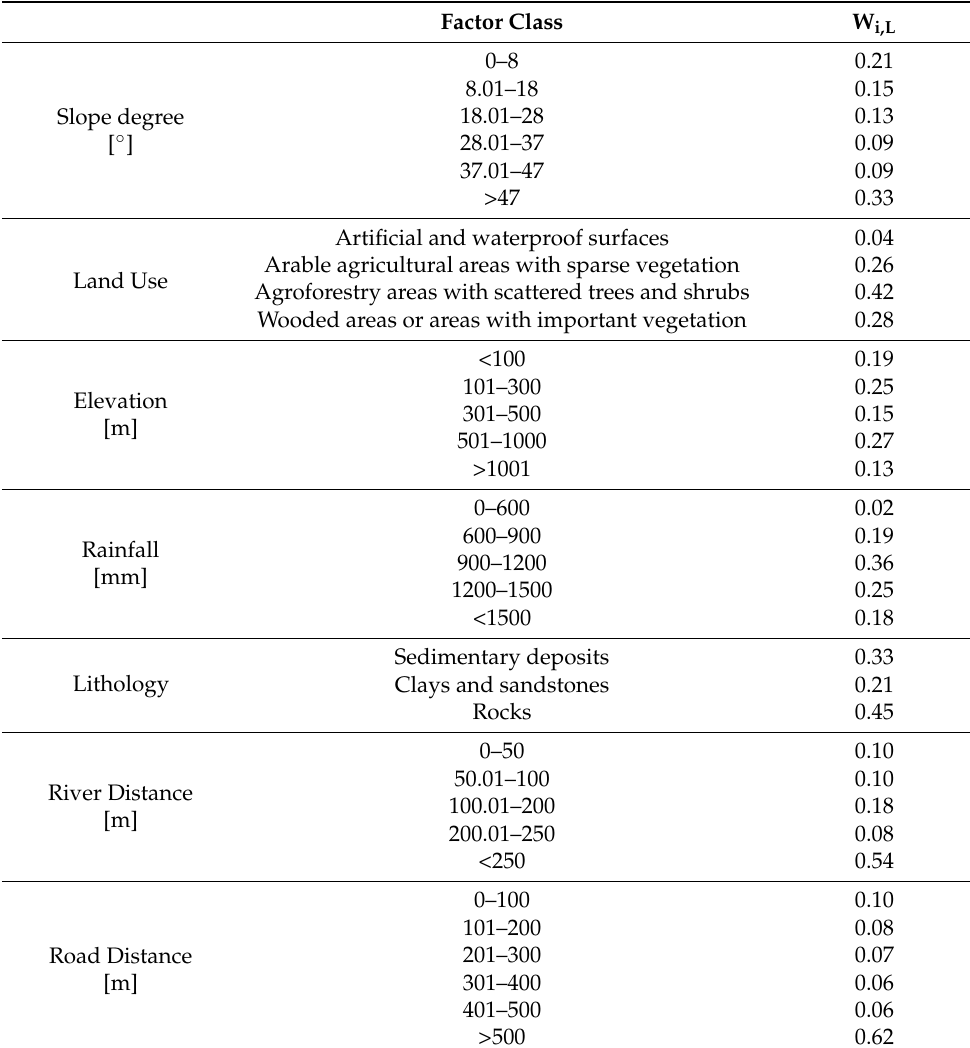
Table 1. Weight of the individual classes of landslide hazard